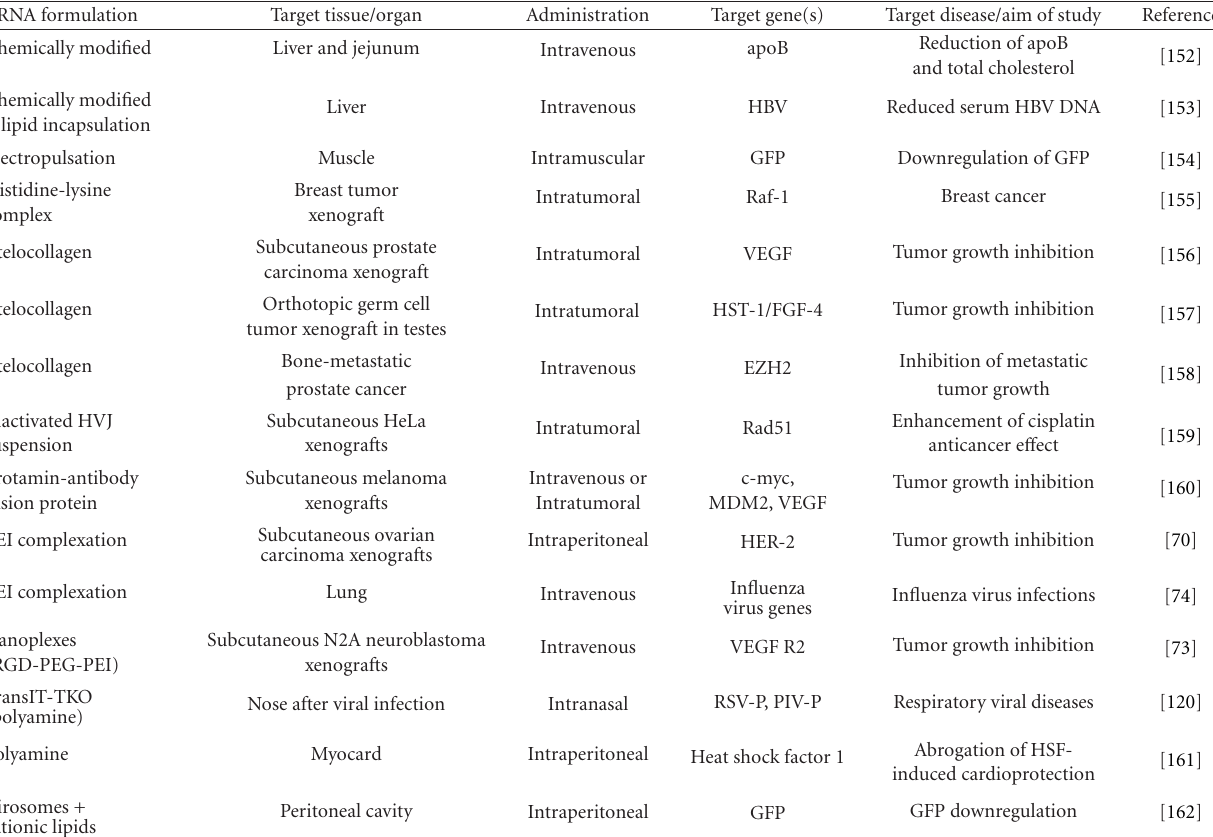
Table 3: Studies based on the direct application of siRNAs to induce RNAi in vivo: other strategies of siRNA administration. siRNA